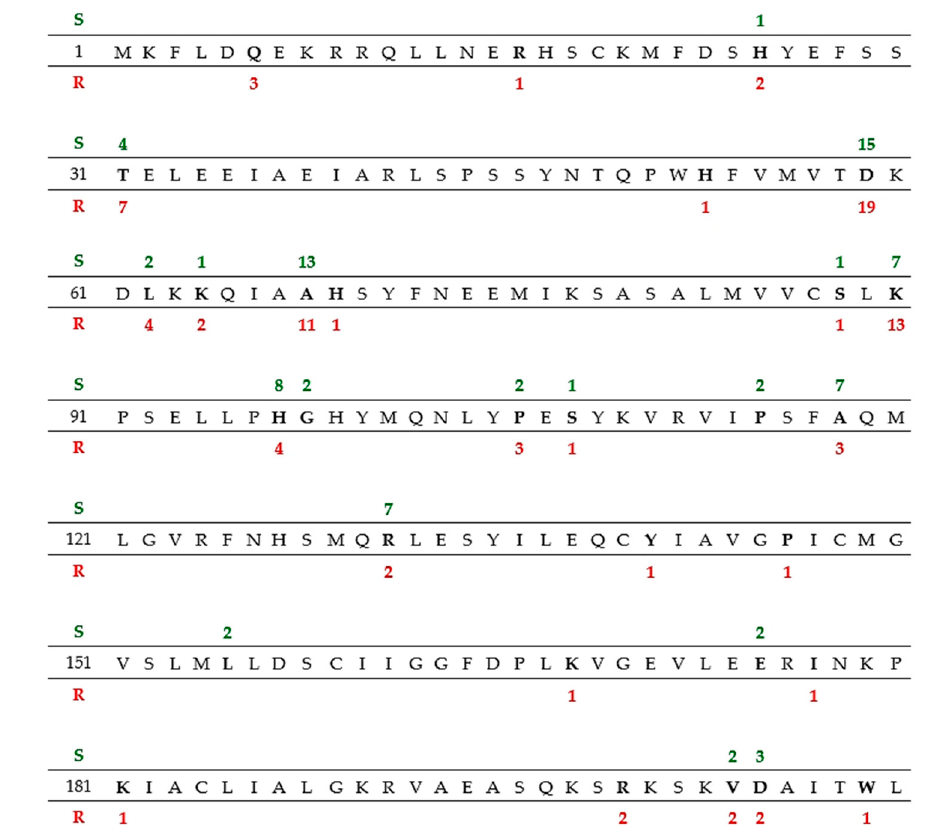
Figure 2. Sequence of the rdxA gene of H. pylori 26695 strain; green numbers above and red numbers below indicate the number of mutations detected in the tested strains that were sensitive (S) and resistant (R) to MET, respectively.